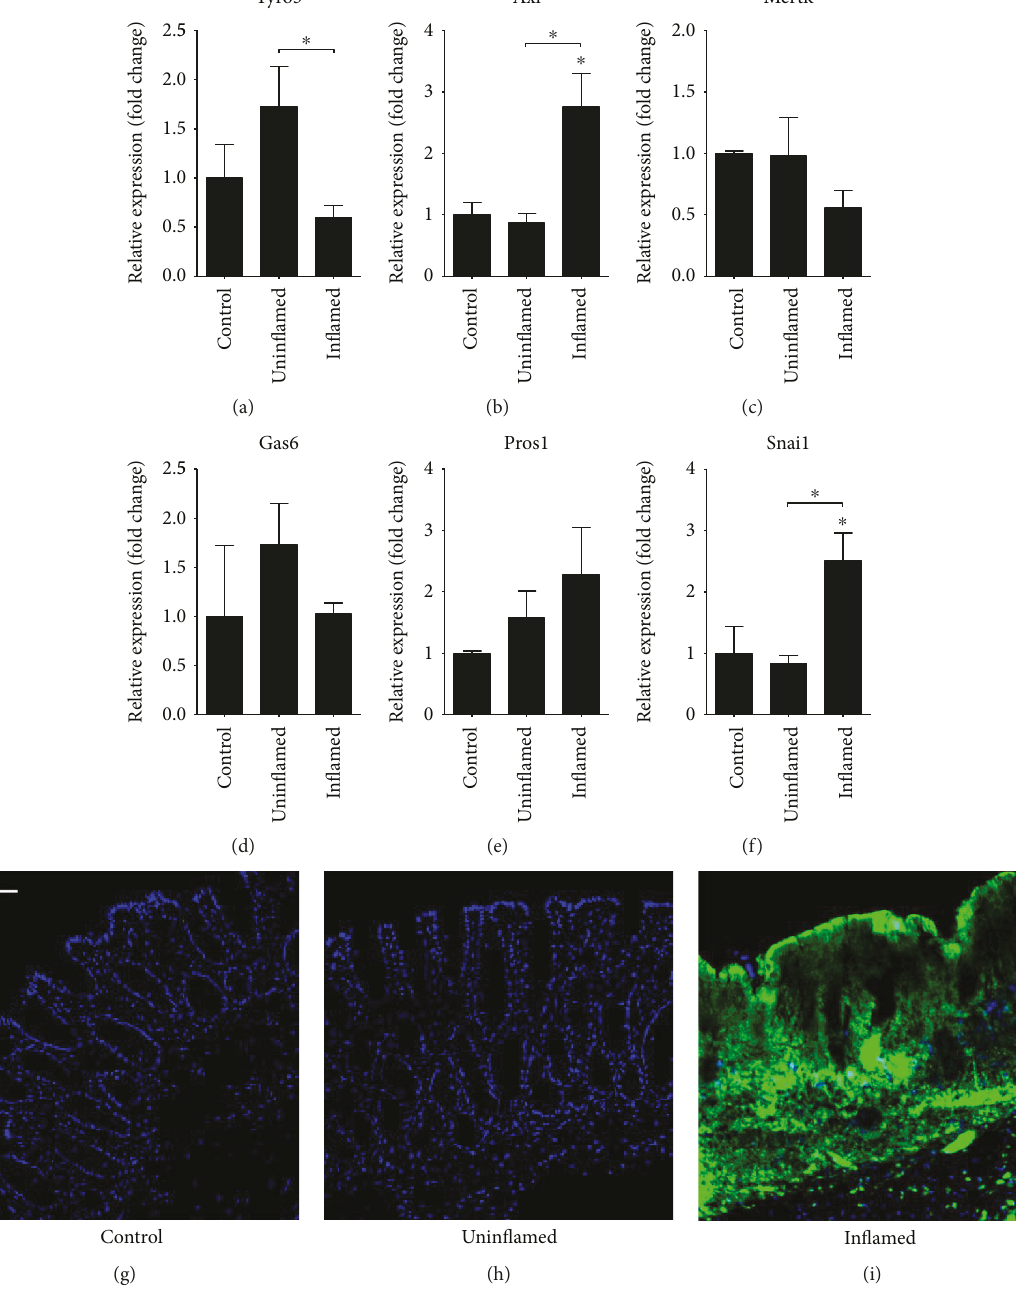
Prism 6 software. Quantitative data are presented as the mean ± SEM, and the signi fi cance of di ff erence between sets of data was determined by one-way analysis of variance (ANOVA) following LSD post hoc test; a p value of less than 0.05 was considered signi fi cant.